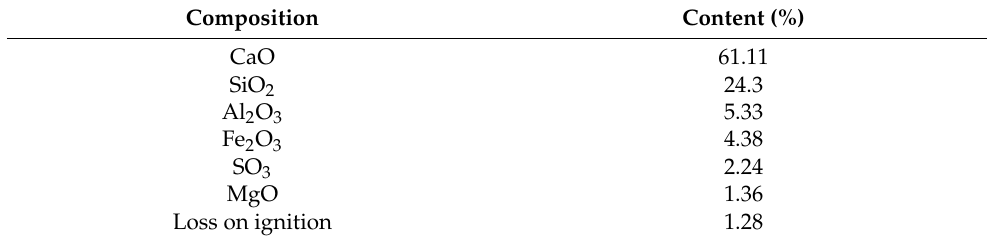
Table 1. Composition of the cement given by the supplier.